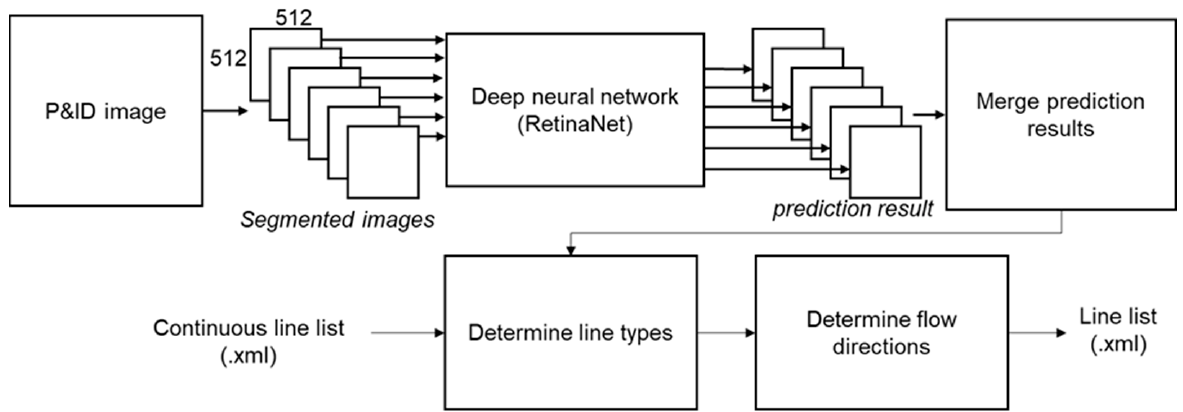
Figure 14. Change of line types and addition of flow directions using a deep learning model.